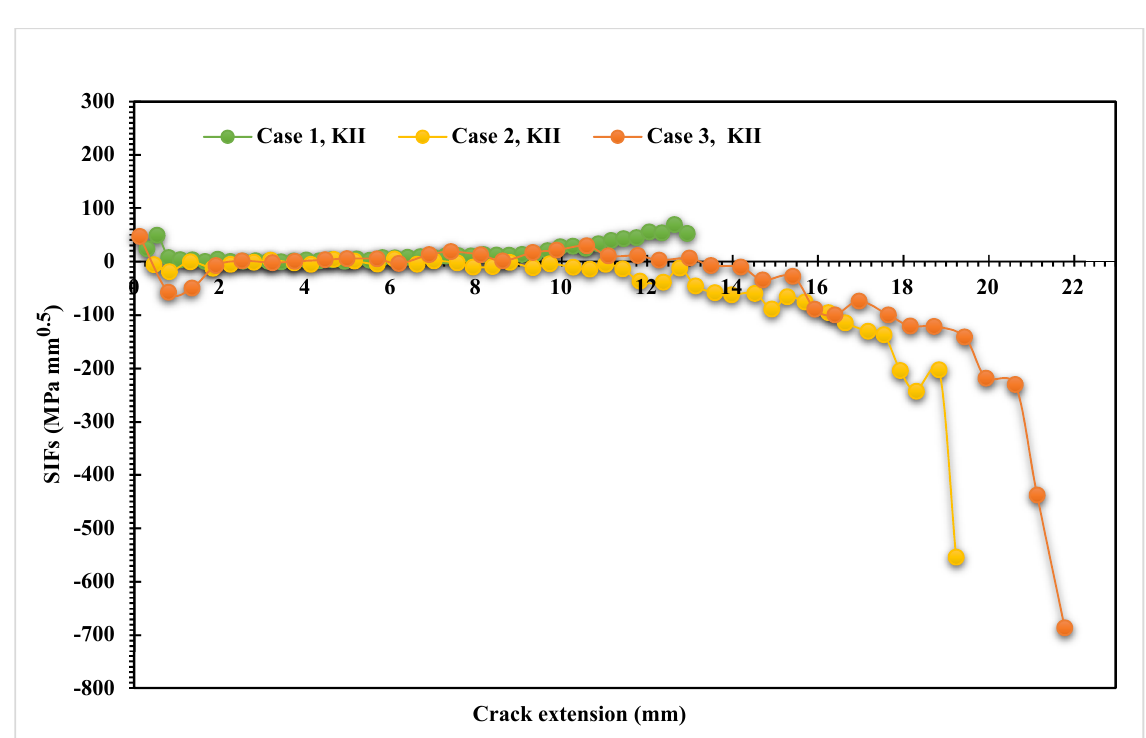
Figure 15. Predicted values of K II for the three different cases.